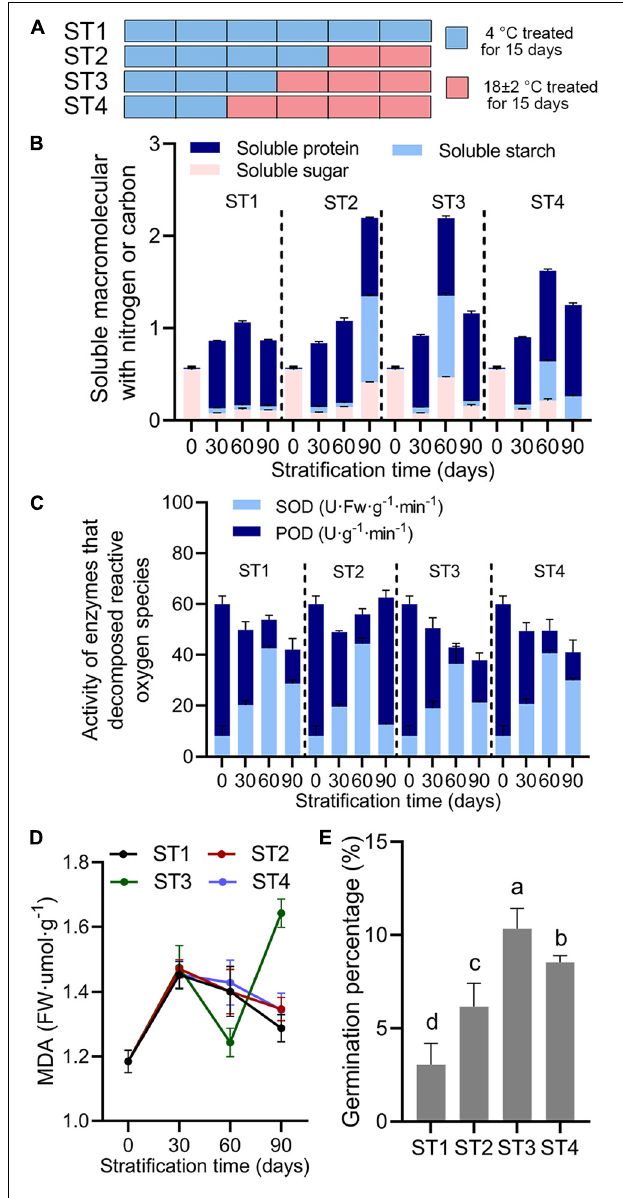
FIGURE 3 | Physiological indices in Rosa rugosa seed embryos after alternate-temperature stratification. (A) Stratification treatments (ST) of seeds with different temperatures and times. Light blue bar indicates seeds were buried by sand at 4 ◦ C for 15 days, and peach bar represents treatment at 18 ± 2 ◦ C for 15 days. (B) Soluble protein, starch, and sugar contents, (C) peroxidase and superoxide dismutase activities, malondialdehyde content (D) , and seed germination percentage (E) among the four stratification treatments showed that embryo physiological activities were most active at 60 days in each stratification treatment. Seeds treated at 4 ◦ C for 45 days followed by 18 ± 2 ◦ C for 15 days (ST3) showed the best removal of physiological